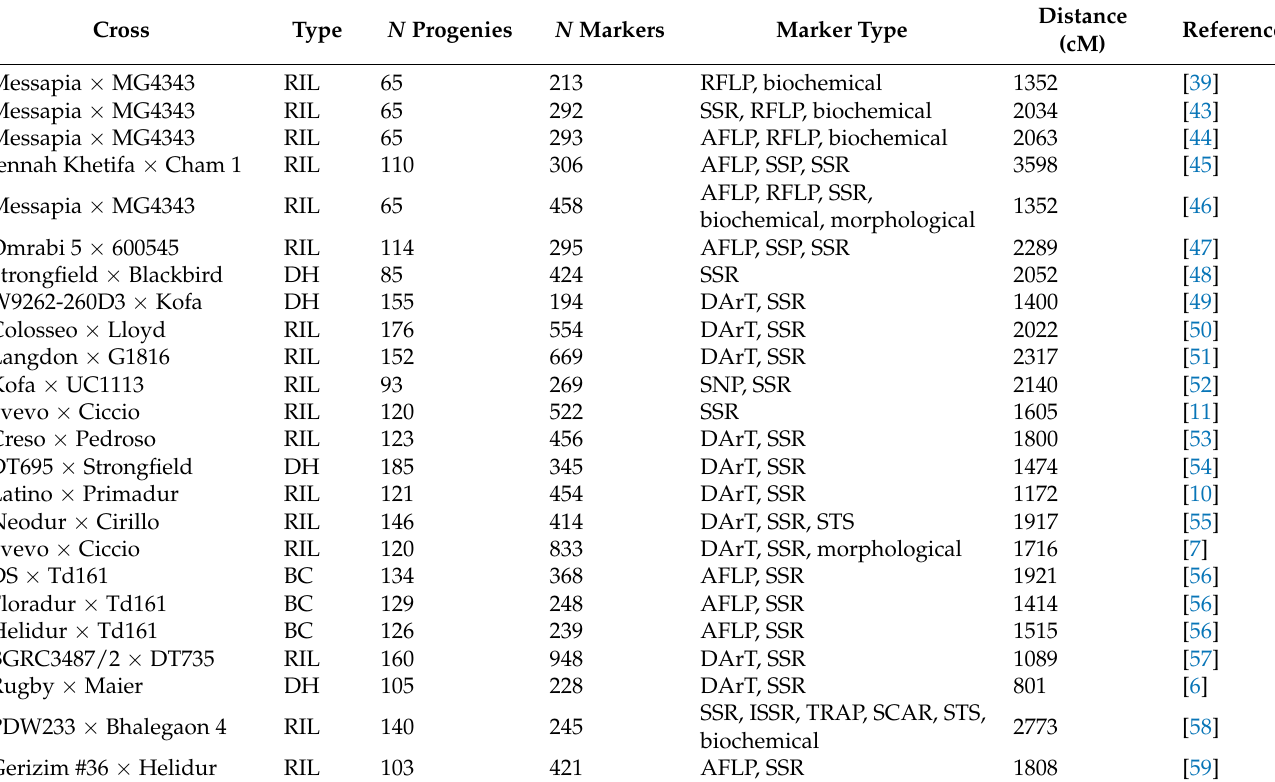
Table 1. Durum wheat linkage